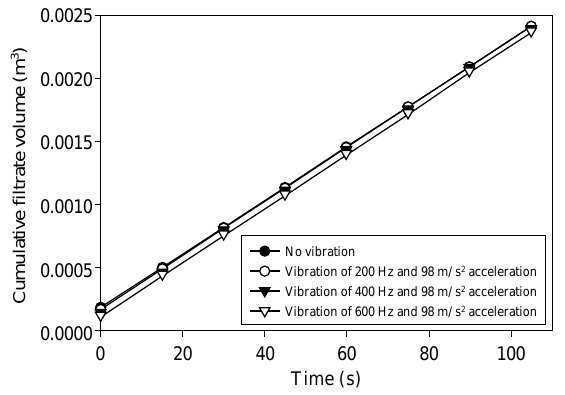
The filtrate volume collected when passing a clean liquid through the filter medium.